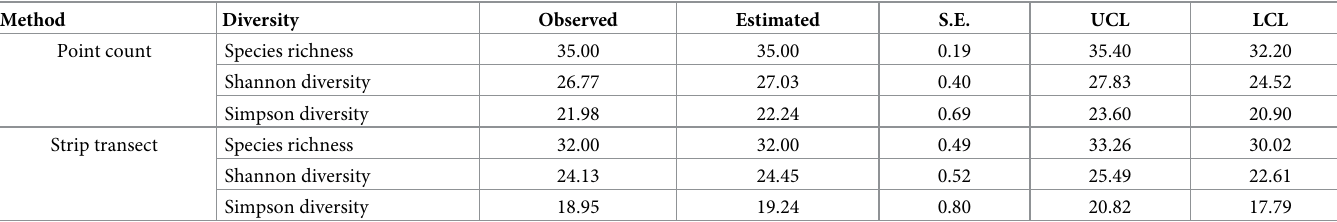
Table 2. Estimates of species richness of raptors in winter seasons from roadside point count and strip transect methods in the arid region of Rajasthan. Method